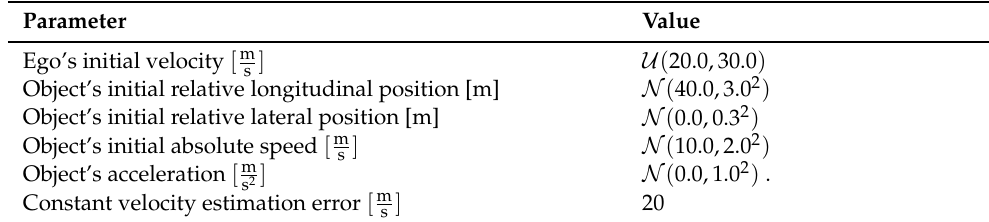
Table A7. Distributions of Scenario B